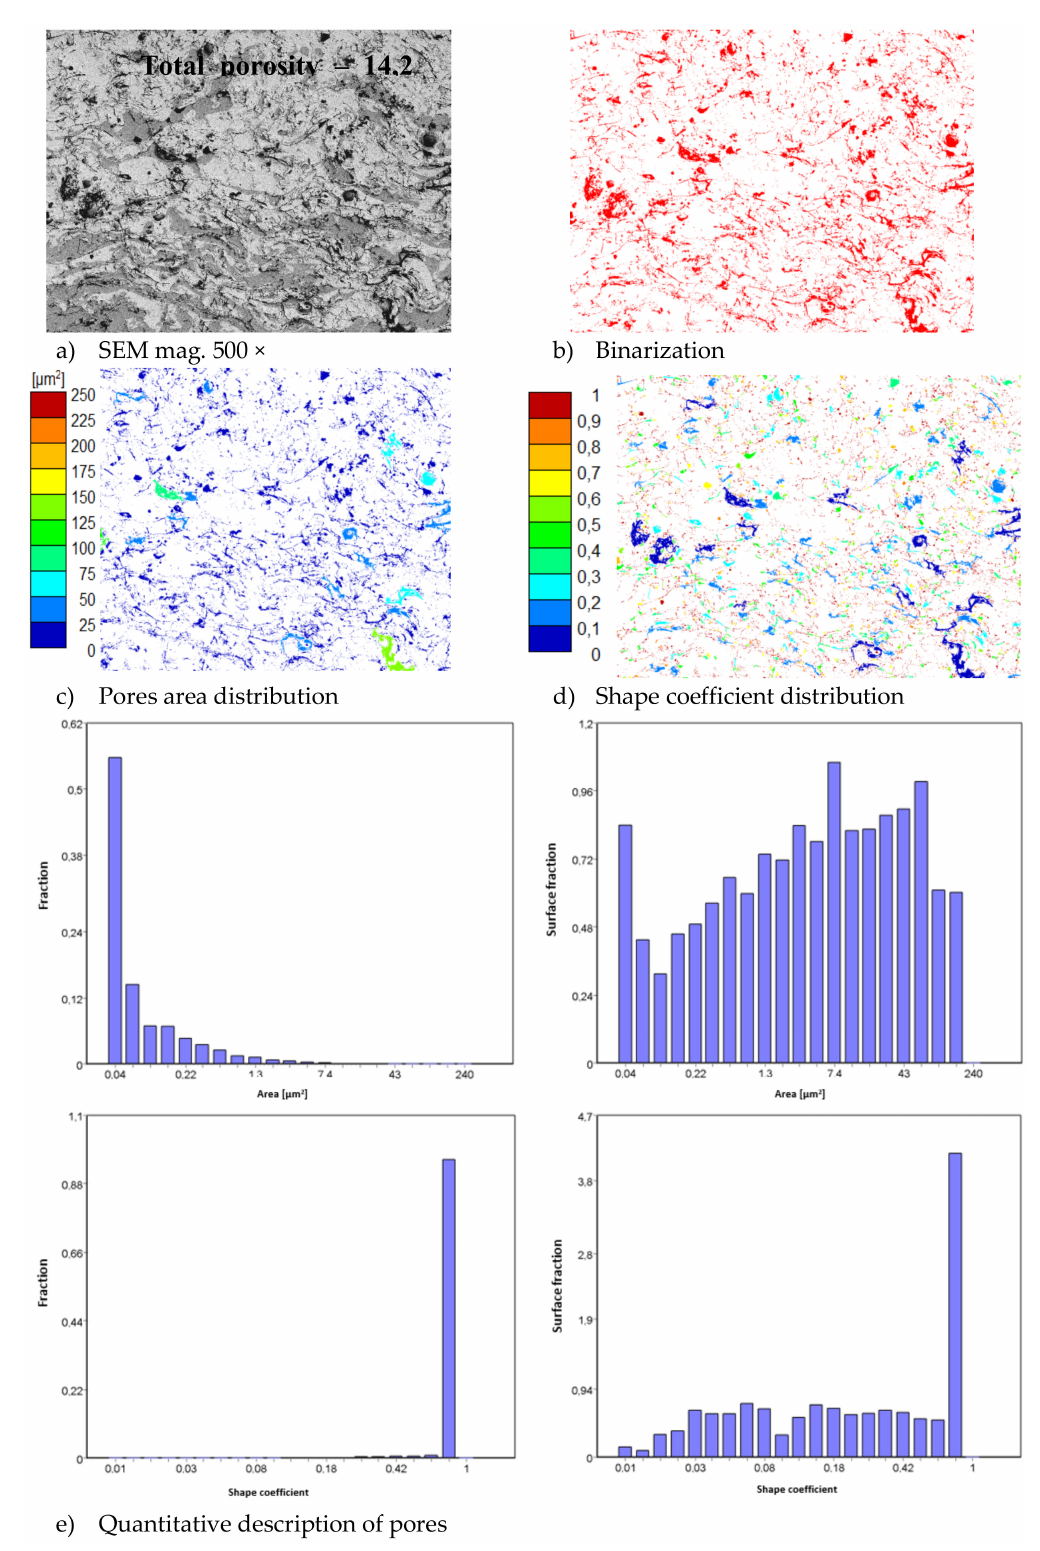
Figure 8. The image analysis results describe pores and voids morphology from quantitative and qualitative points of view for the DCL La 2 Zr 2 O 7 / 50% La 2 Zr 2 O 7 + 50% 8YSZ / 8YSZ system: ( a ) SEM image, ( b ) binarization of pores and cracks, ( c ) visual evaluation of pores area distribution, ( d ) visual evaluation of pores shape coe ffi cient distribution, ( e ) quantitative evaluation of pores area and shape coe ffi cient